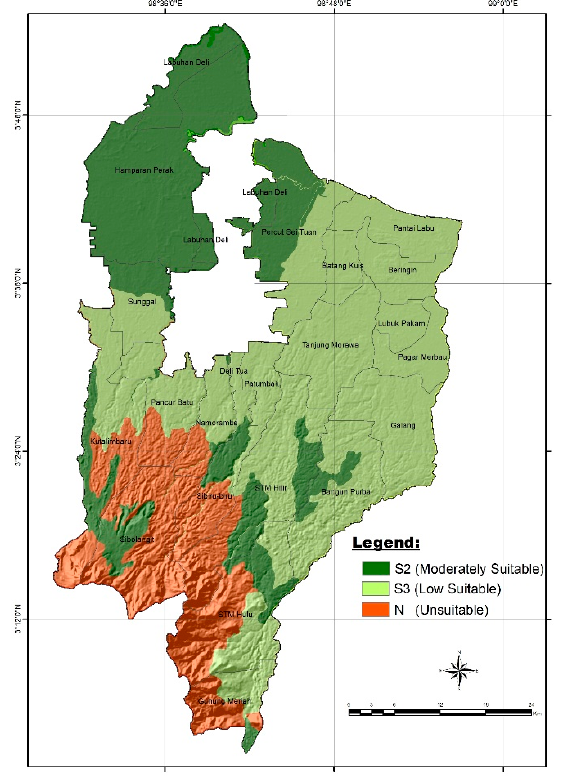
Figure 5. The land suitability map for rice in 2018.